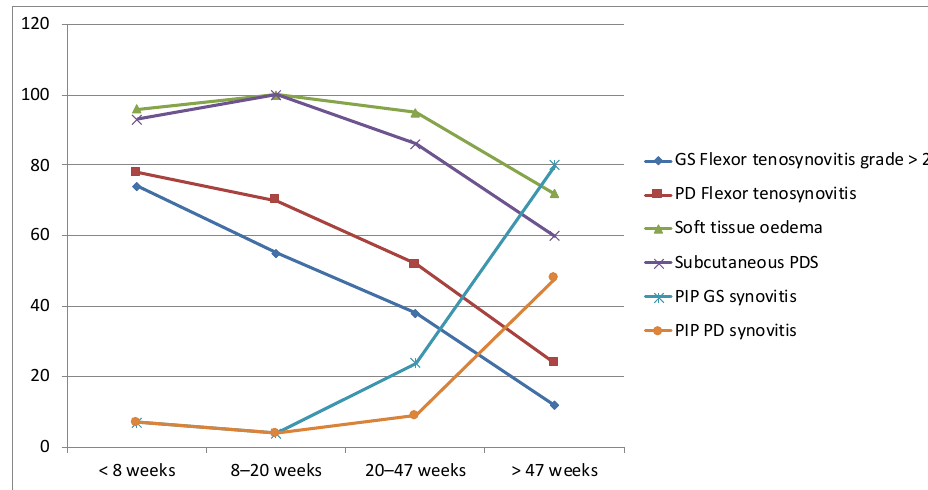
Figure 3. Prevalence of some US abnormalities after splitting cases into quartiles based on dactylitis duration: US: ultrasound; GS: greyscale; PD: power Doppler; PDS: subcutaneous PD signal; PIP: proximal interphalangeal. Figure reproduced from the article: Girolimetto et al. J Rheumatol.